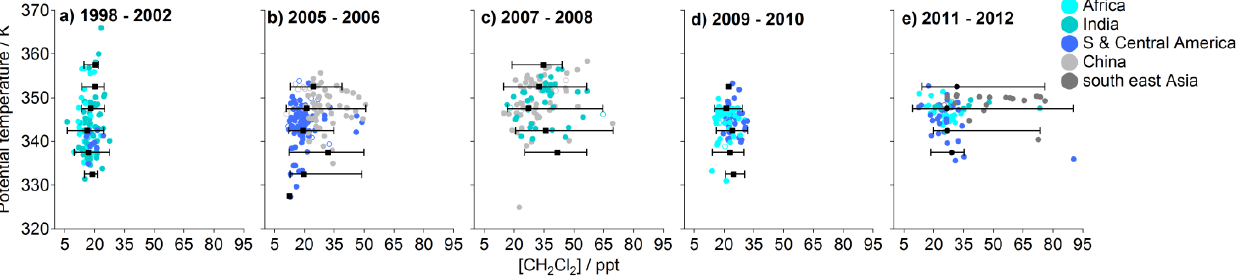
Figure 7. Profiles of CH 2 Cl 2 relative to O 3 from samples collected on flights across the North and Central Atlantic to Central America. Median values are for 50ppb O 3 bins between 0–100ppbv and 100ppbv O 3 bins above this, error bars are 1 σ . The coloured band highlights the region between 400–500ppbv O 3 discussed in Sect. 3.4. The dashed line represents 30ppt of CH 2 Cl 2 (see Sect. 1), provided as a visual marker to illustrate the shift over time to higher concentrations of CH 2 Cl 2 .